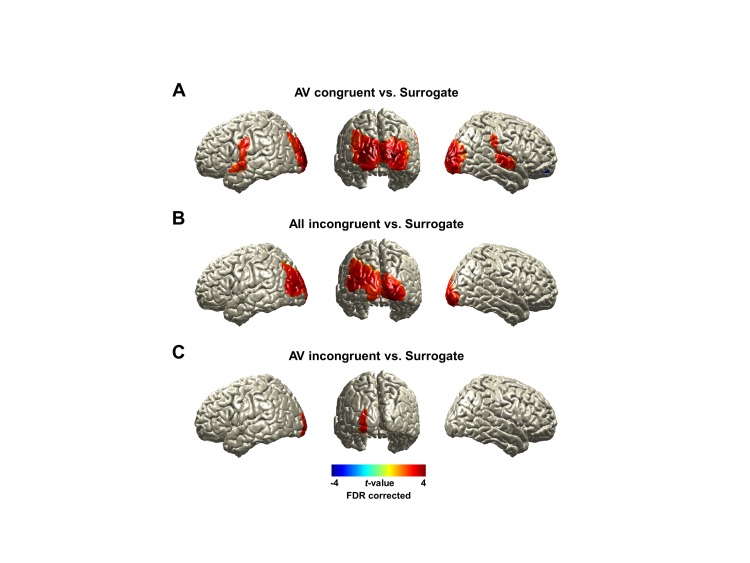
Brain activity entrained by lip movements.We show lip-entrained brain activity by coherence in natural audiovisual speech condition (All congruent) at 1 Hz (dominant frequency component in lip signals) in Figure 2D. Here we show the same effect for other experimental conditions compared to surrogate data. (A) AV congruent: Lip entrainment in the AV congruent condition showed similar pattern to All congruent condition (Figure 2D). Distributed bilateral visual areas, auditory areas, left pre/postcentral gyri and right postcentral, supramarginal gyri were observed (p<0.05, FDR corrected). (B) All incongruent: Lip entrainment in this condition revealed increased involvement of bilateral visual cortex. This result confirms that there is clear lip entrainment effect irrespective of sound speech entrainment since this shows robust visual entrainment in the absence of a congruent sound speech input in All incongruent condition (p<0.05, FDR corrected). (C) AV incongruent: Compared to the other conditions lip entrainment is evident but reduced. Even though there is a congruent sound speech input as in the AV congruent condition, this does not reveal lip entrainment effect as strong as in the AV congruent condition providing more evidence that lip entrainment is modulated by attention (p <0.05, FDR corrected).